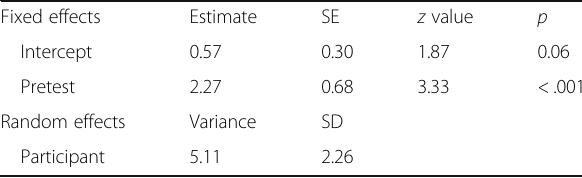
Table 4 Model parameters for additional items Fixed